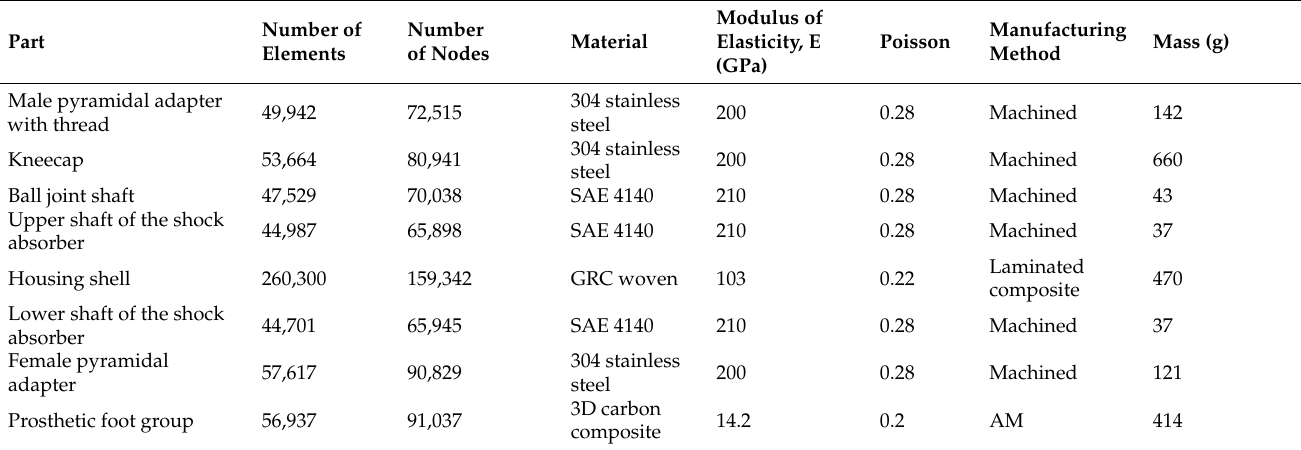
Table 1. Details of nodes, material, mechanical properties, manufacturing method, and mass for each part.